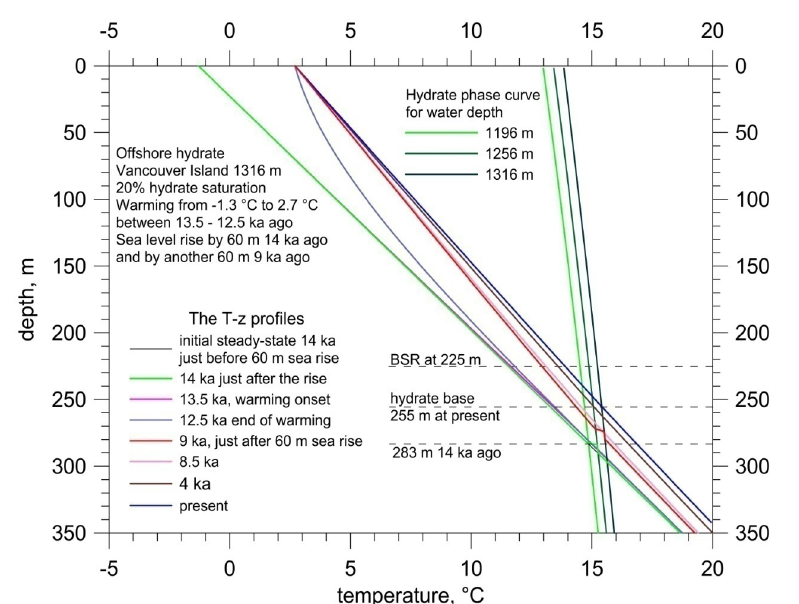
Figure 4. Temperature depth and hydrate phase curve for water depth 1196–1316m for the marine hydrate Vancouver Island case of postglacial warming and related sea bottom